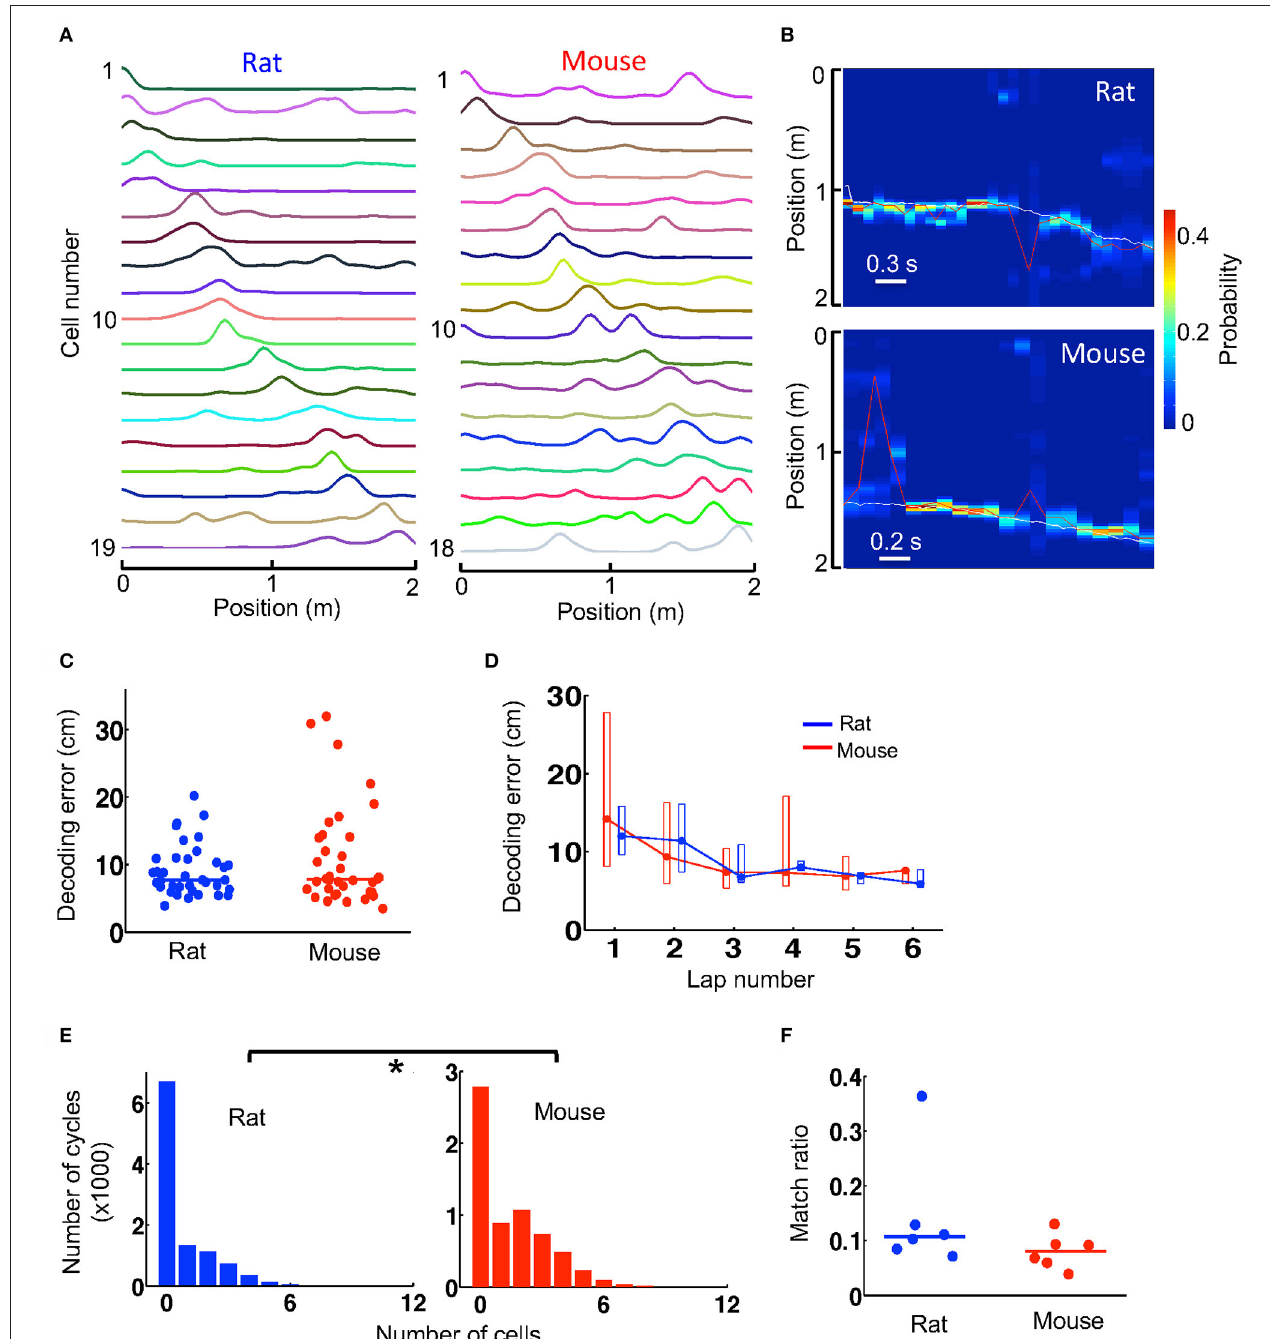
FIGURE 4 | Spatial locations during track running were decoded with similar accuracy from mouse and rat place cell activities. (A) An example rat template and an example mouse template on a trajectory. Each line is the firing rate curve of a place cell. (B) Decoded probability of each position at each time point (100ms) for a track running period of a rat and for a running period of a mouse. The decoding was based on the two templates in (A) . Color represents decoded probability. Red line: decoded position (peak probability location) at each time point. White line: animal’s actual position. Note the close match between the decoded (red) and actual (white) positions at most of the time points. (C) Decoding error of every lap for all rats and mice during running of the novel track. Lines: median values. (D) Lap-by-lap decoding error (median and [25, 75%] range values). (E) Histograms of rat and mouse theta cycles with different number of active template cells. * P < 0.05. (F) Match ratio of the number of theta cycles within which decoded positions matched a portion of the track over all candidate theta cycles. Each dot is a trajectory of an animal.